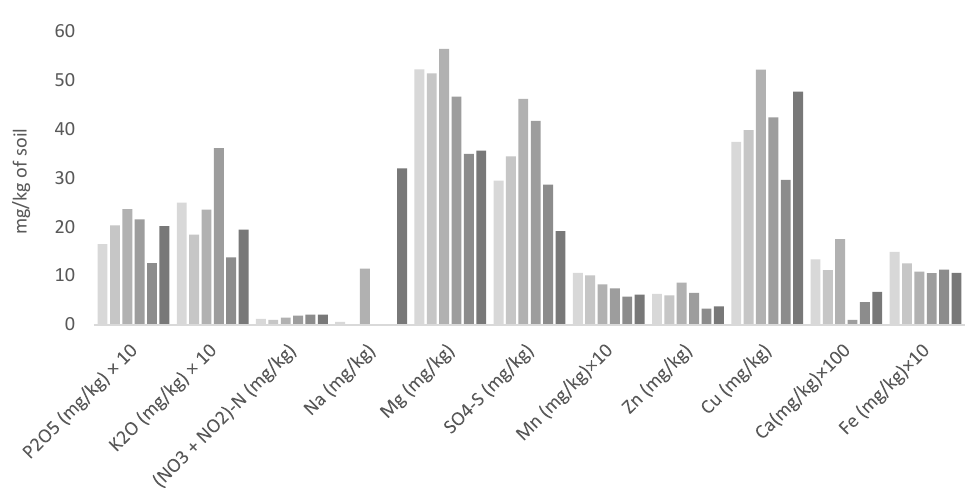
Figure 2. Nutrient contents of soil in the sampled vineyards at two depths (0–30 and 30–60 cm) (based on thelaboratoryreportofNAIK-SZBKI-Badacsony,anaccreditedsoillaboratory). INT:Intensivelycultivated;